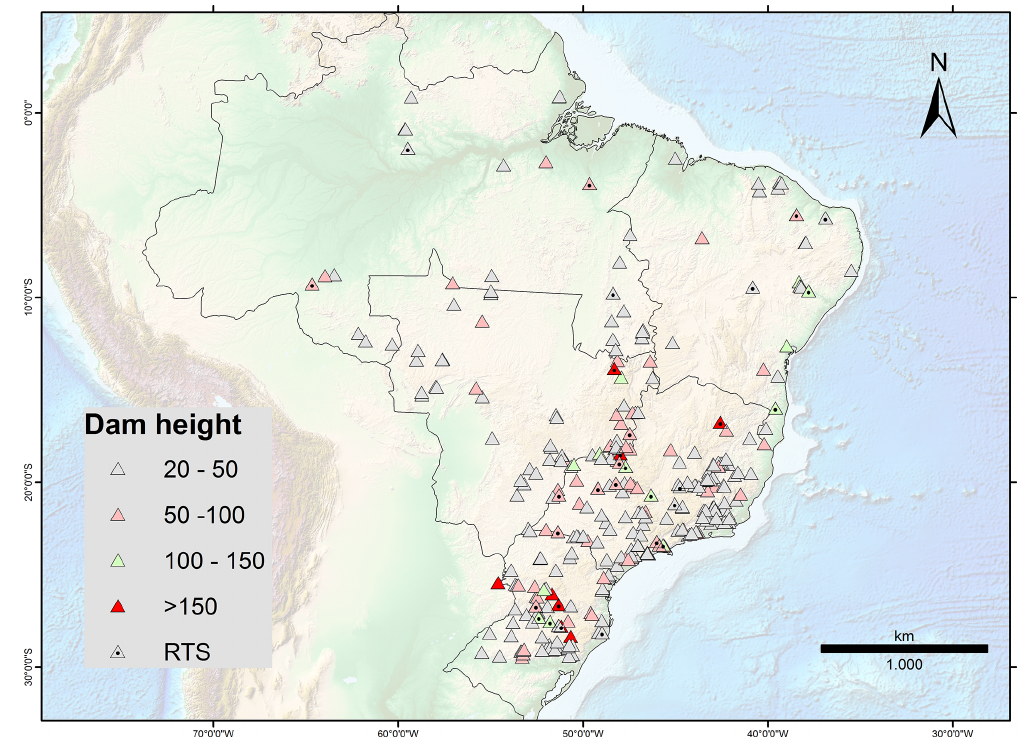
Figure 8. Map showing the location and classification by the dam height. Data by Brazilian Committee on Dams.